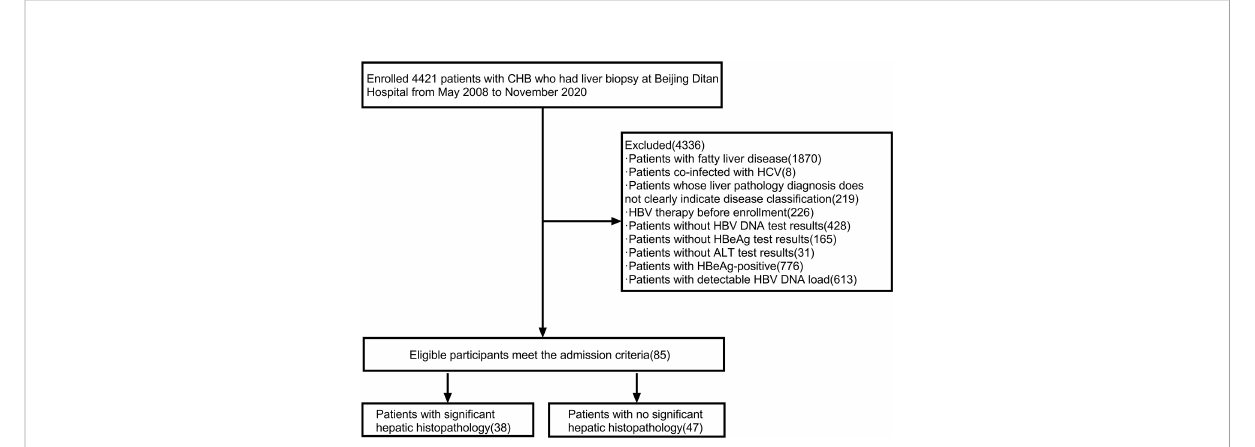
FIGURE 1 Flow chart for screening research patients. Abbreviations: ALT, alanine aminotransferase; CHB, chronic hepatitis B; HBV DNA, hepatitis B virus deoxyribonucleic acid; HBV, hepatitis B virus; HCV, hepatitis C virus; HBeAg, hepatitis B e